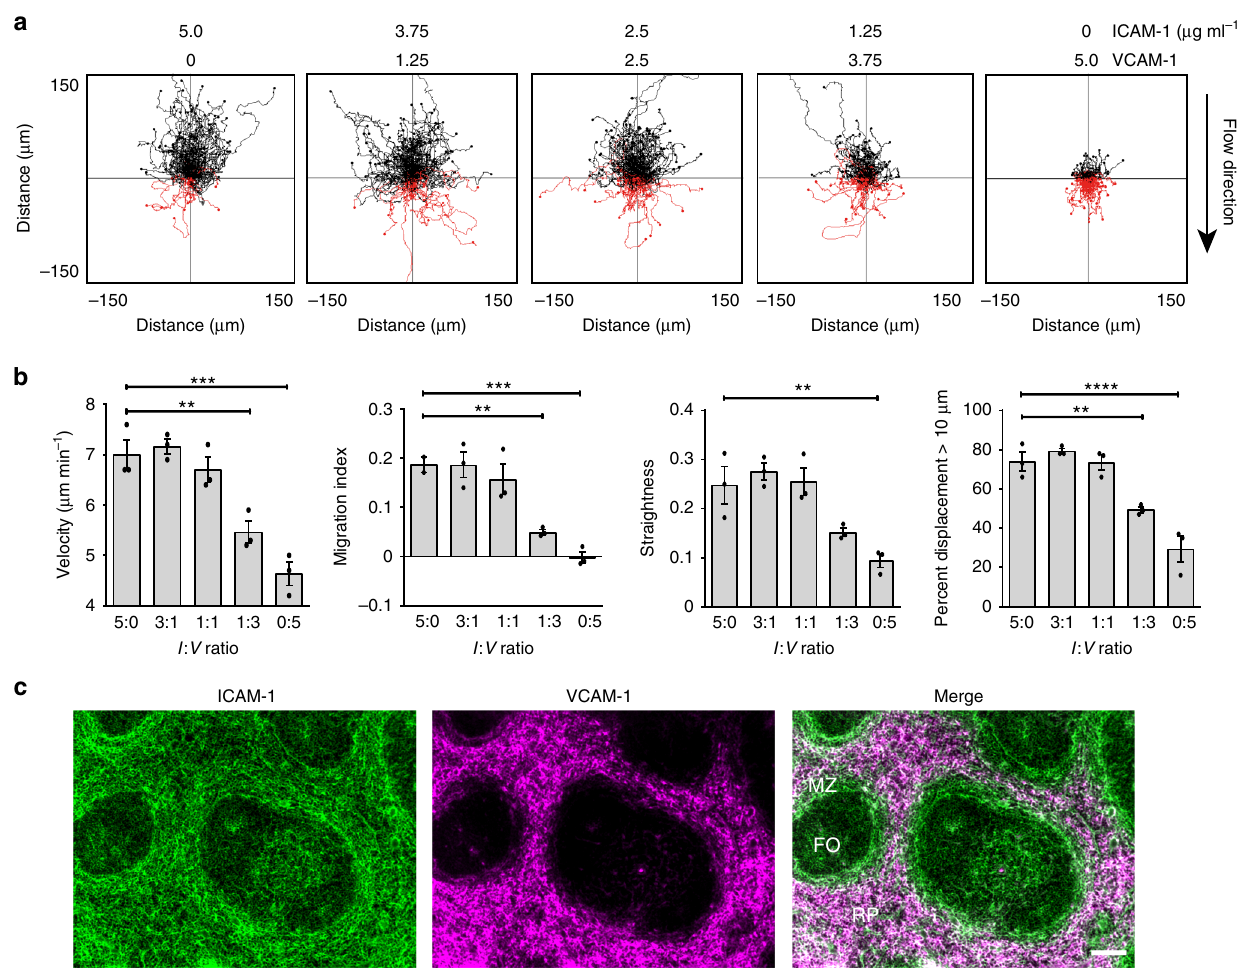
Fig. 2 MZBs migrate up the fl ow on ICAM-1 but not on VCAM-1. a Representative track plots of MZB migration up the fl ow (8 dyn cm − 2 ; direction indicated by arrow) with coating (ICAM-1 or VCAM-1) amounts shown above. b Quanti fi cation of velocity, straightness, migration index, and % of cells with displacement > 10 µ m for the ICAM-1 to VCAM-1 (IV) ratios shown above in a . All four graphs show different parameters from the same set of experiments; bars show mean ± SEM. Data are from three experiments with one mouse each. Symbols in one condition group denote the three replicates and represent the average of 100 – 200 cells from each individual mouse. c Microscopy of ICAM-1 (green), VCAM-1 (magenta), and the merge (white) in the spleen, showing follicles (FO), marginal zone (MZ), and red pulp (RP). Data represent two experiments with one spleen each. Scale bar; 100 µ m. ** P < 0.01, *** P < 0.001, **** P < 0.0001, one-way ANOVA with Dunnett post hoc tests comparing all ICAM-1/VCAM-1 mixtures to ICAM-1 alone